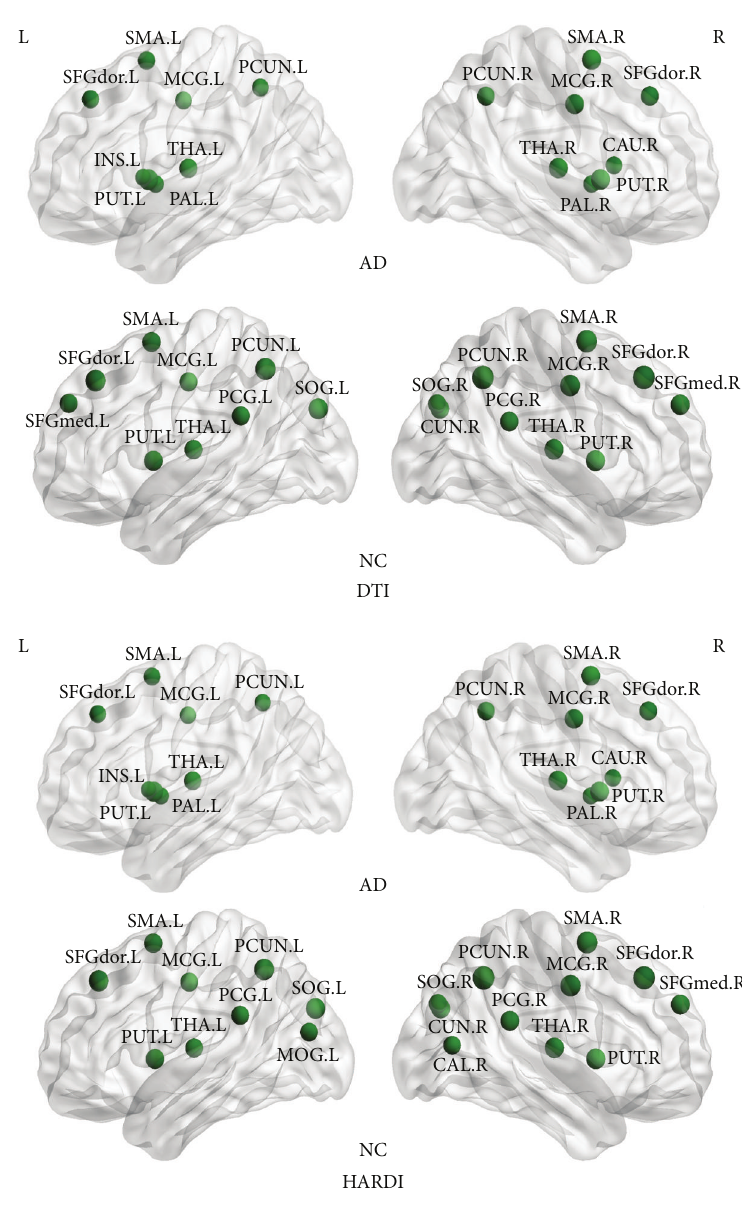
Figure 4: Hubs in the AD group and the NC group given by the DTI method and the HARDI method, respectively. Each sphere represents the center of an ROI. Refer to Table 2 for the label of each